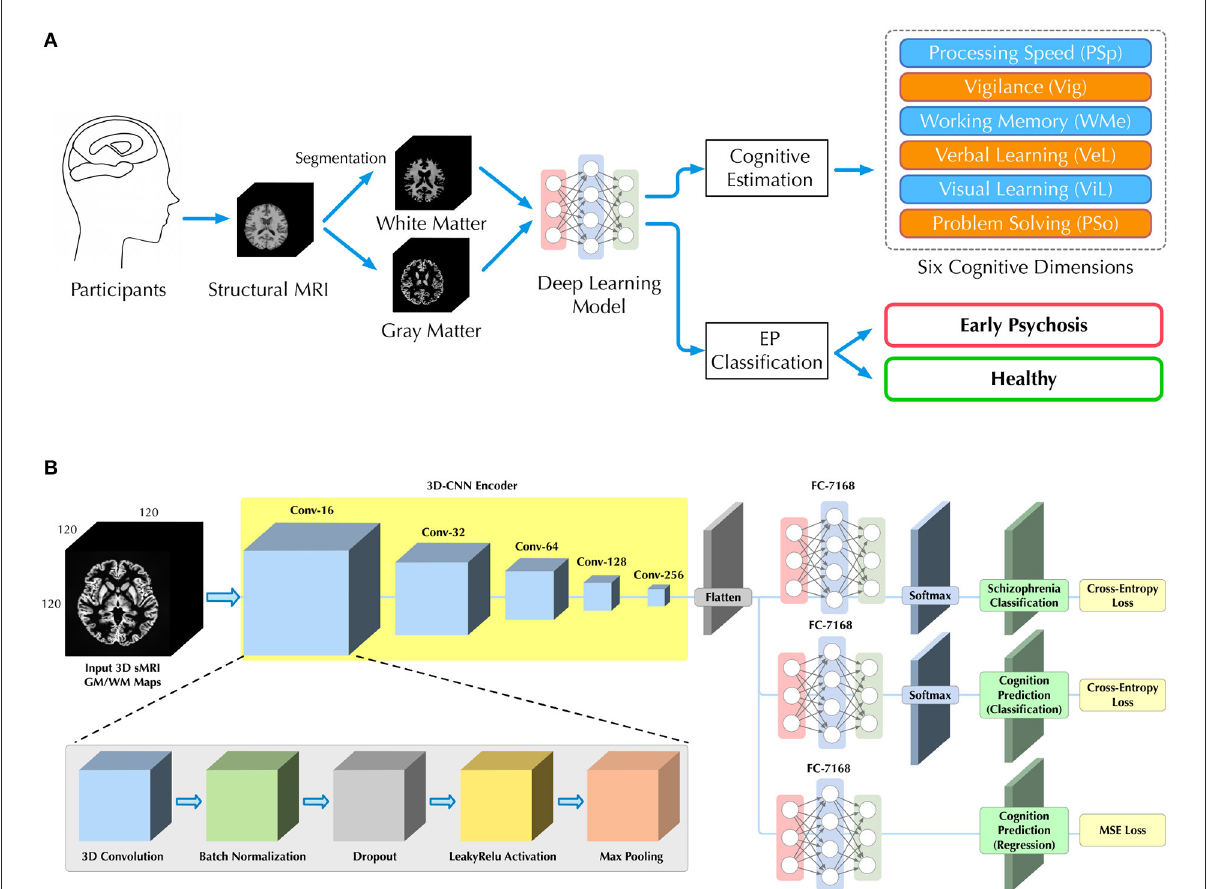
FIGURE1 Illustrations of (A) our workflow for classification of patients with EP from HCs and cognitive estimation on six dimensions, and (B) the deep learning architecture with a 3D-CNN feature encoder and three independent MLP subbranches for different subtasks of EP classification and cognitive